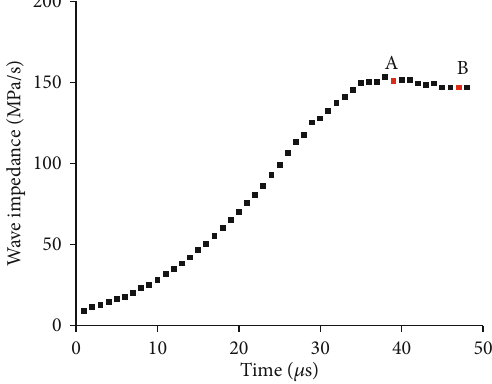
Figure 15: Trend chart of wave impedance over time.